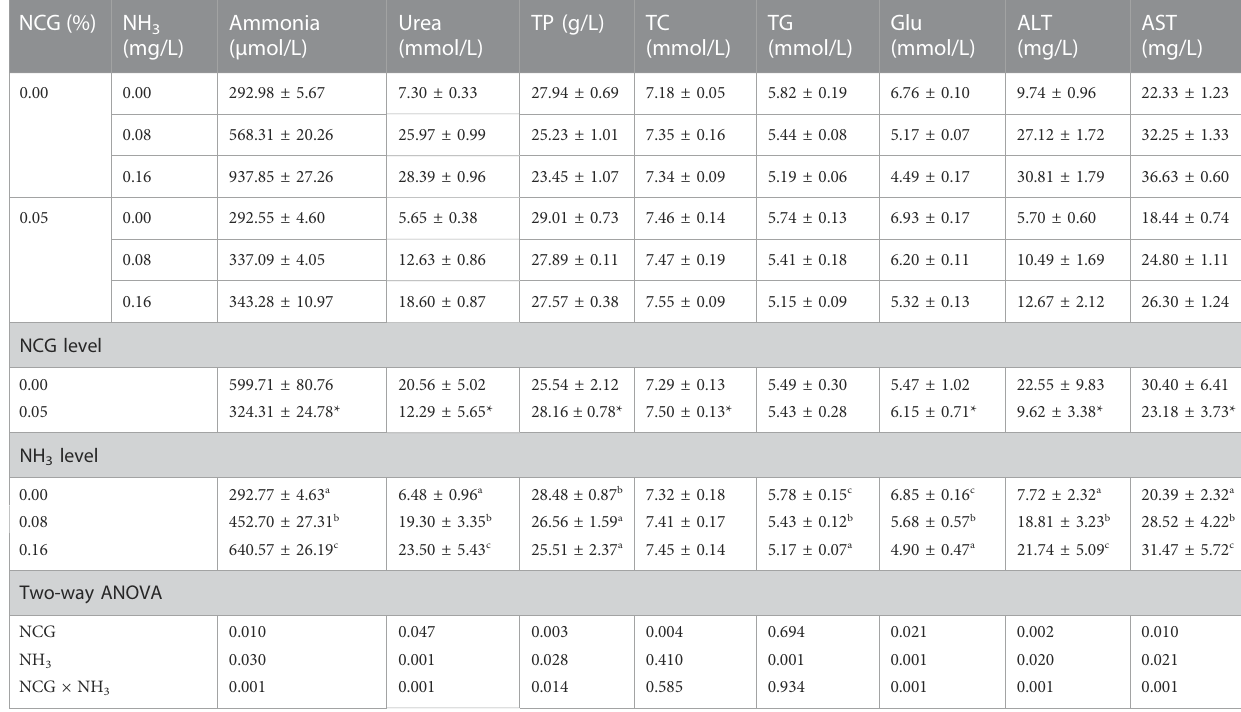
TABLE 5 Effects of dietary N -carbamylglutamate supplementation on serum biochemical index of yellow cat fi sh exposed to different ammonia levels for 84